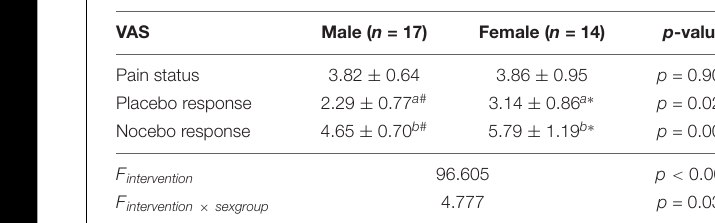
TABLE 1 | Summary of general data of the 31